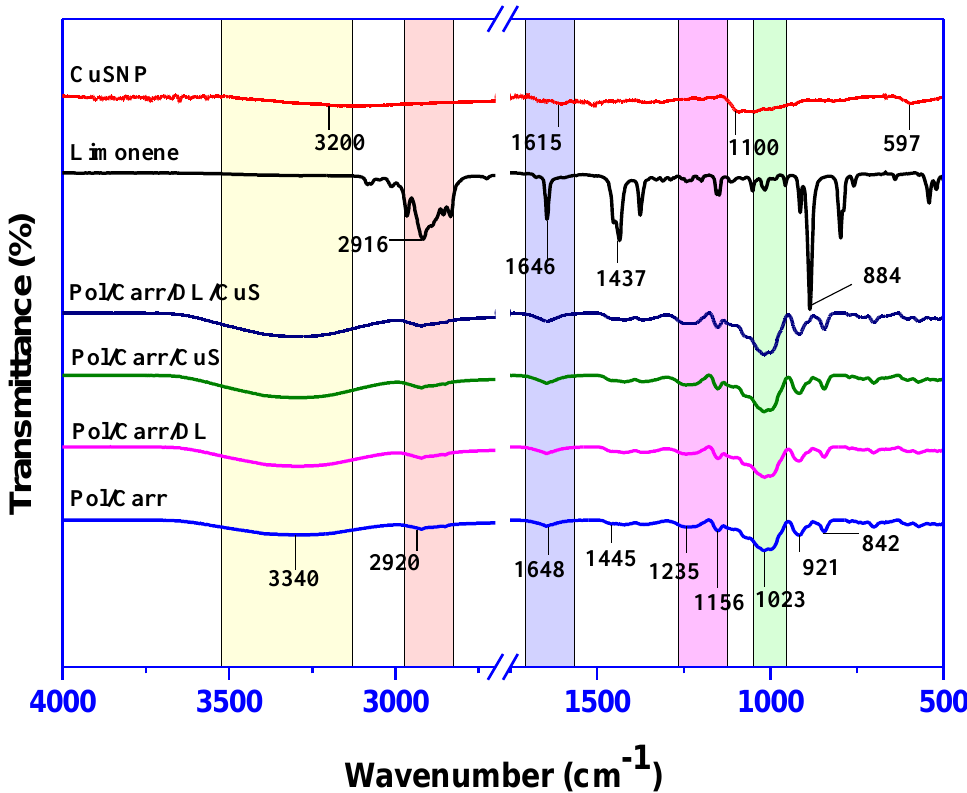
Figure 3. FTIR spectra of CuSNP, DL, and pullulan / carrageenan-based films.